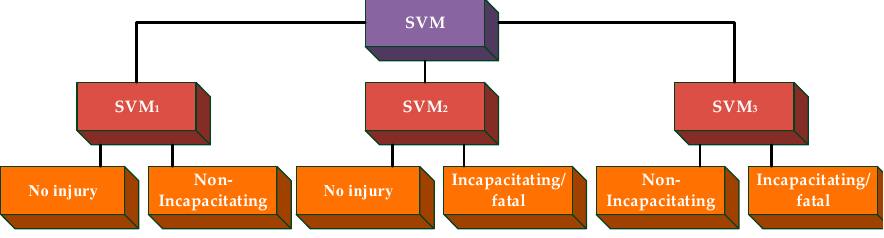
Figure 4. Multi-classifier construction of Libsvm.